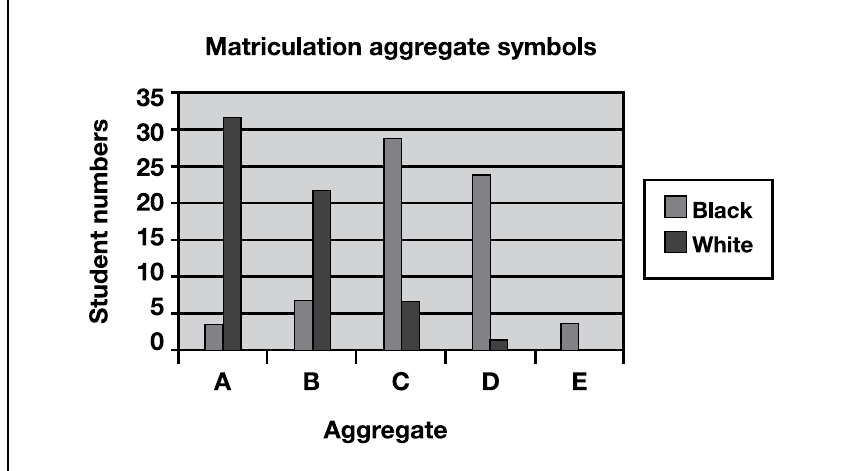
Figure 1: Matriculation aggregate symbols for black and white